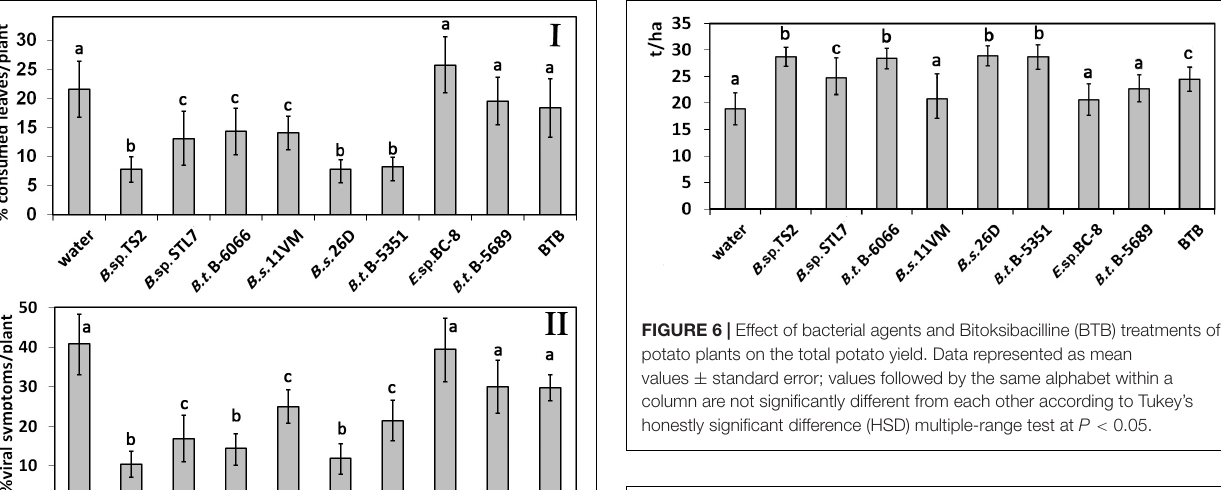
BC-8, B. thuringiensis B-5689, and biocontrol agent BTB did not